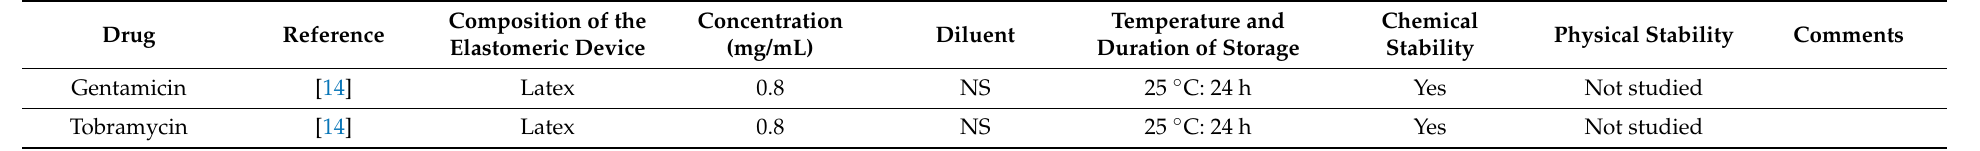
Table 4. Stability of aminoglycosides in elastomeric devices.